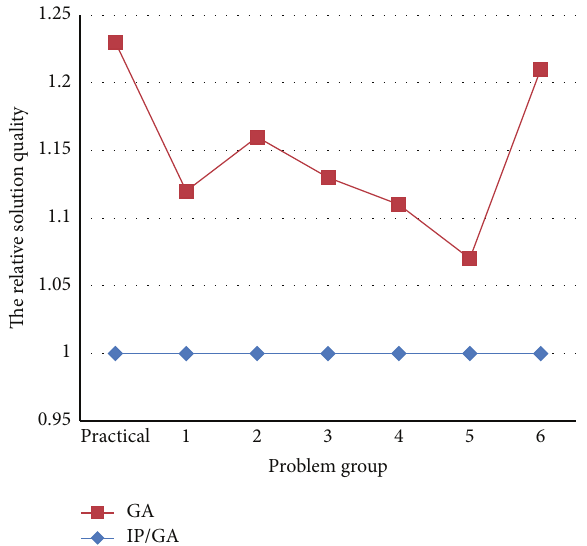
Figure 6: The ARD comparison of the IP/GA from an existing